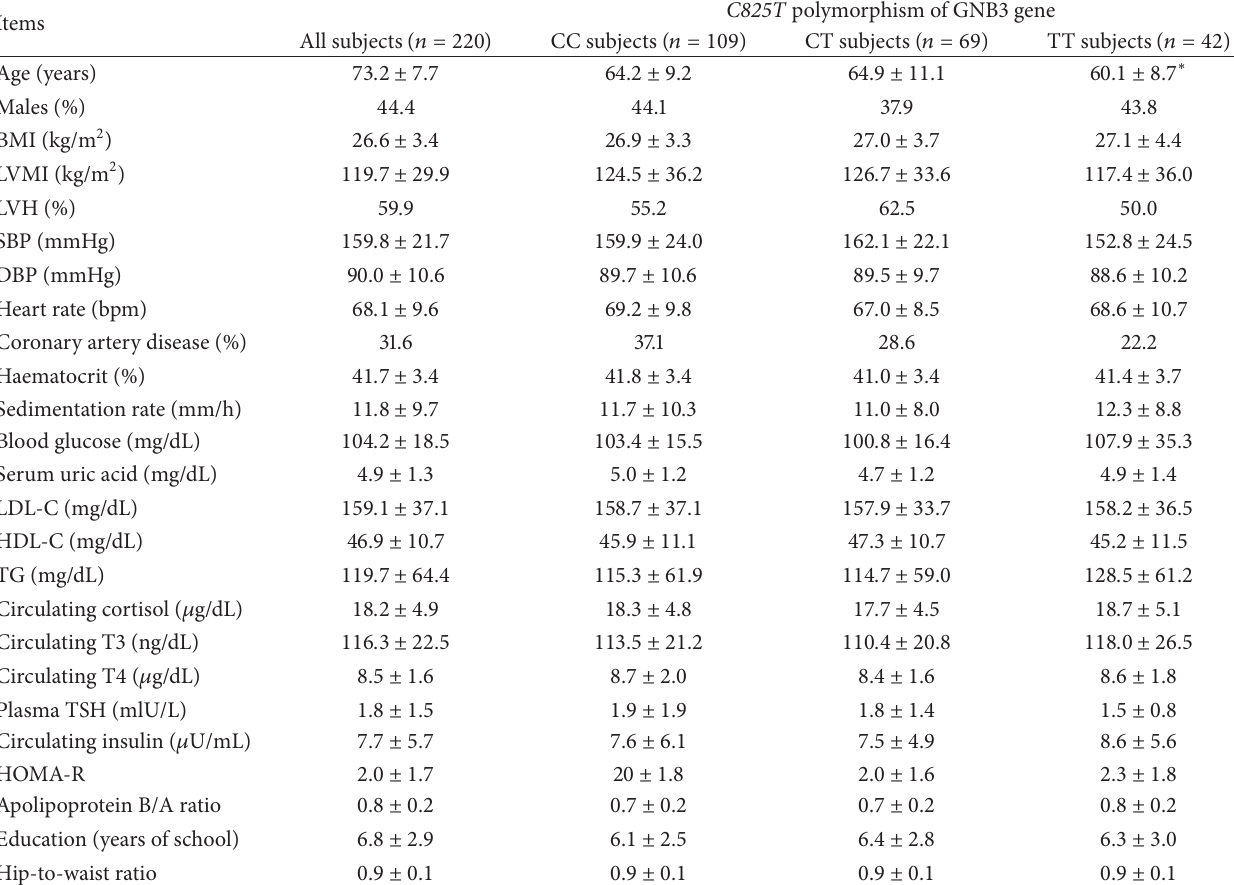
Table 1: General characteristics of the study cohort. Mean ± standard deviations are provided for continuous